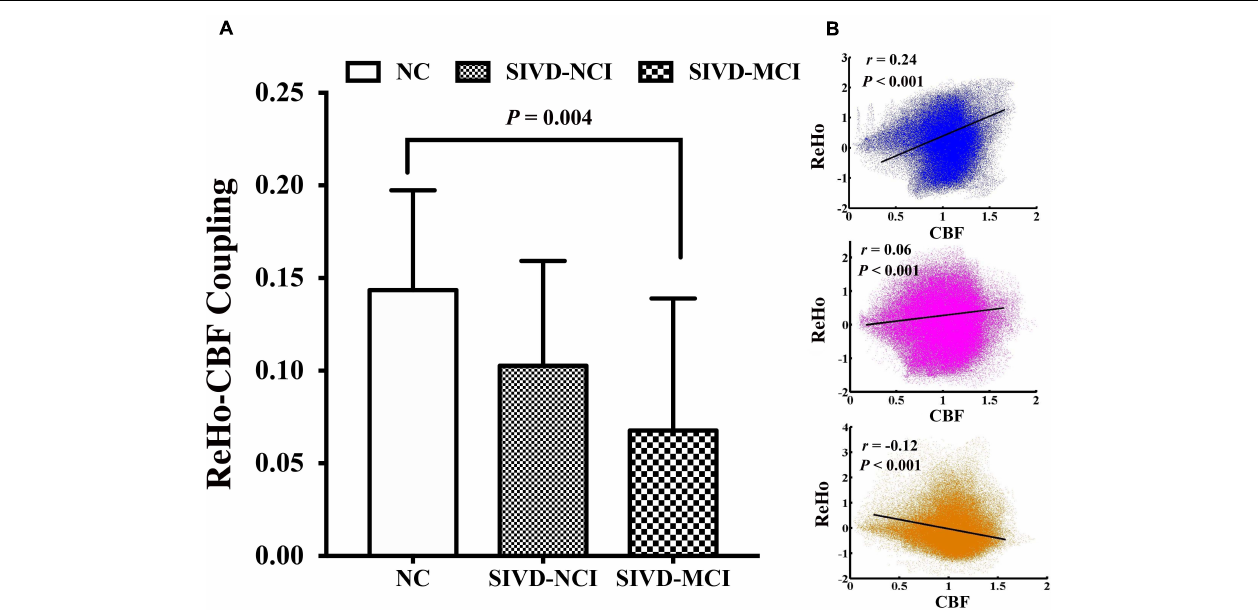
FIGURE 1 | (A) Global ReHo–CBF coupling changes among three groups; SIVD-MCI group shows a significantly reduced ReHo–CBF coupling compared with NC group ( P = 0.004). (B) Scatter plots of spatial correlation across voxels between ReHo and CBF of a normal control (blue; r = 0.24, P < 0.001); a SIVD-NCI patient (red; r = 0.06, P < 0.001) and a SIVD-MCI patient (orange; r = –0.12, P < 0.001).